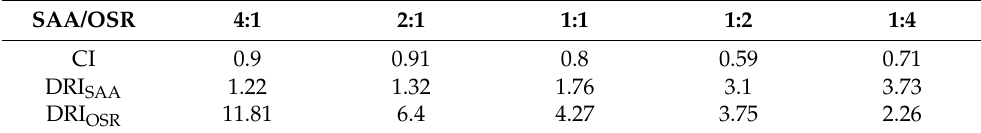
Figure 3. Analysis of synergism of salvianolic acid A (SAA) and oxysophoridine (OSR) on H8 cells. ( A ) Chemical structure of salvianolic acid A (SAA) and oxysophoridine (OSR). ( B ) Inhibitory effect of SAA and OSR on H8 cells. ( C ) Inhibitory effect of different proportions of SAA and OSR on H8 cells. ( D ) Plots of Fa-CI in different ratios by the Chou–Talalay method; (* p < 0.05, ** p < 0.01, *** p < 0.001). The synergistic effects of SAA and OSR on H8 cells were studied by the Chou–Talalay method [27–30]. Figure 3C shows that the inhibitory effect of SAA combined with OSR on H8 cells was stronger than that of SAA alone. The synergistic indices CI and DRI are shown in Figure 3D and Table 2. When Fa = 0.5 (inhibition rate = 50%) and SAA/OSR = 1:2, we obtained the lowest CI of 0.59, which had a relatively good synergistic effect. The IC 50 value of SAA decreased from 5.74 ± 0.63 µ M to 1.87 ± 0.37 µ M, and the IC 50 value of OSR decreased from 13.70 ± 1.71 µ M to 3.73 ± 0.74 µ M (Table 3). The DRI values were greater than 1, indicating synergism. Table 2. Combination index (CI) and dose-reduction index (DRI) of SAA and OSR on H8 cells.